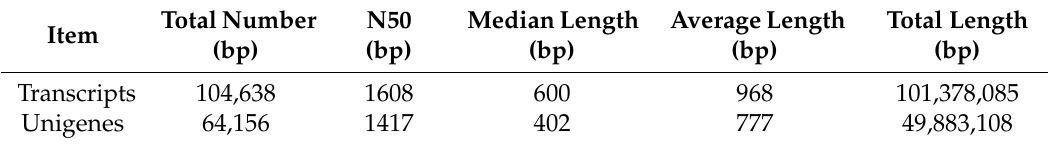
Table 2. Statistics of de novo assembly of sequence reads.